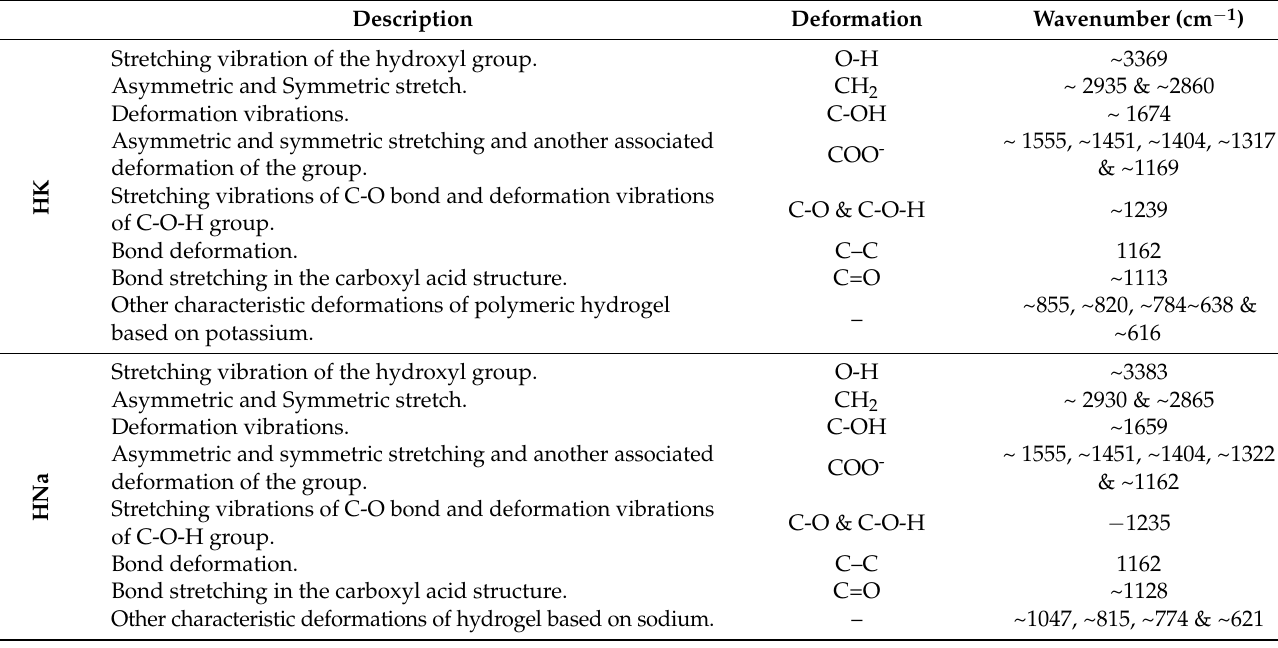
Table 2. Characteristic Bands of hydrogels based on potassium and sodium